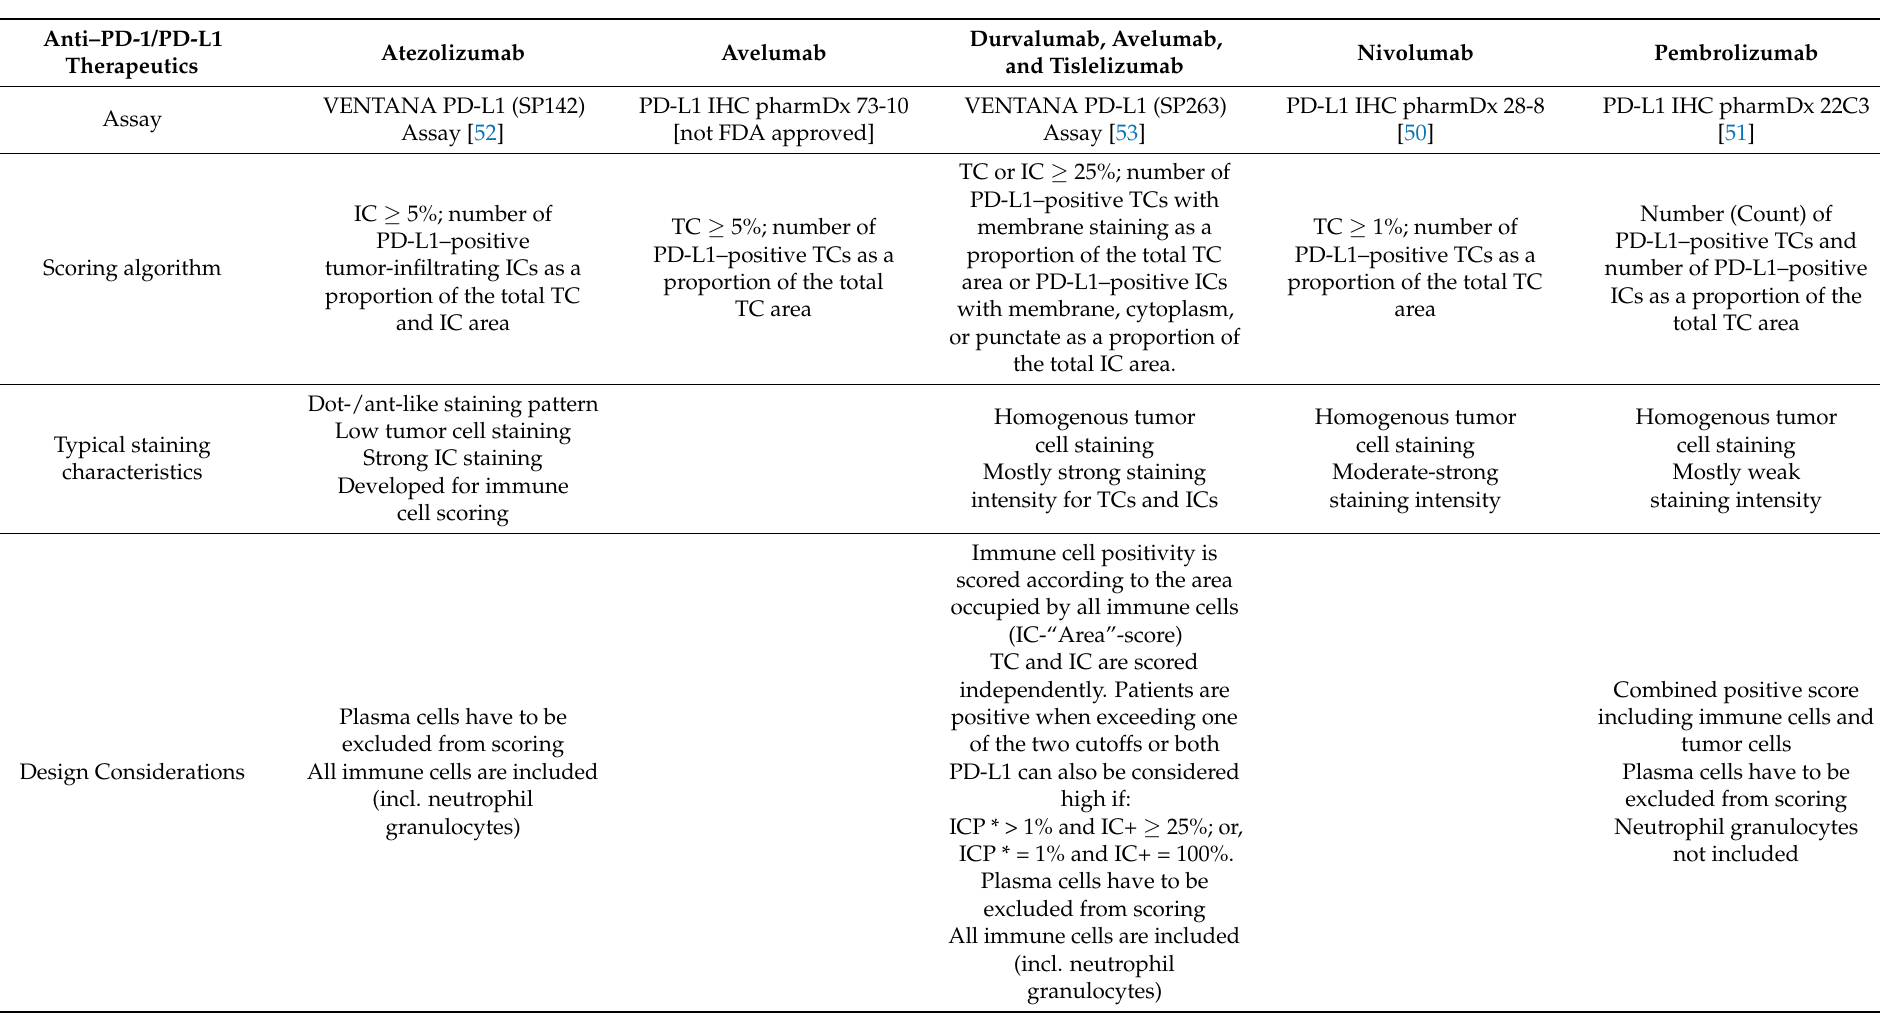
Table 1. Scoring algorithms for the companion diagnostic assays of immuno-oncology (IO)